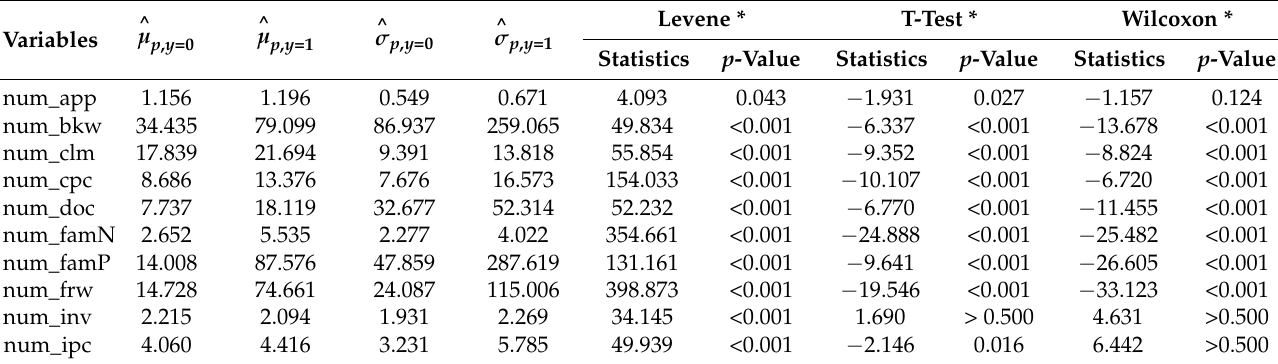
Table 4. Results of statistical test for Hypothesis